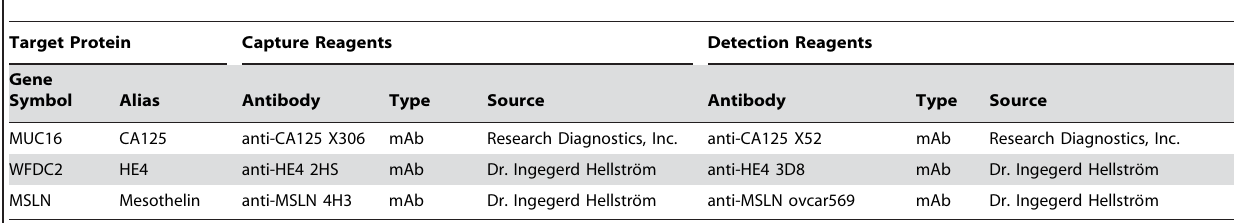
Table 7. Bead-based immunoassay